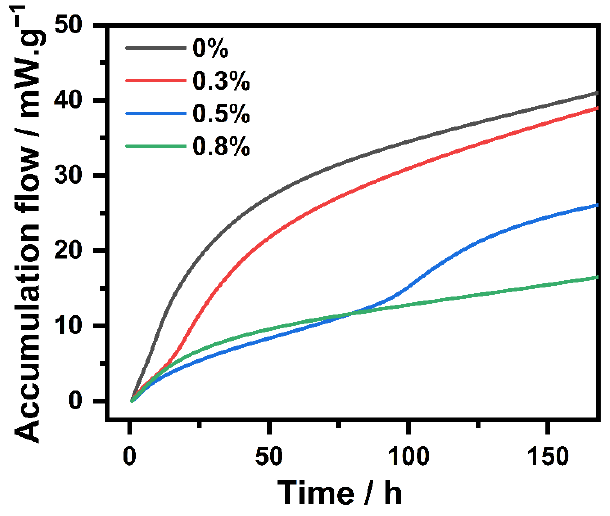
Figure 10. Influence that IBMA content has on the accumulation flow of the hydration of NHL.